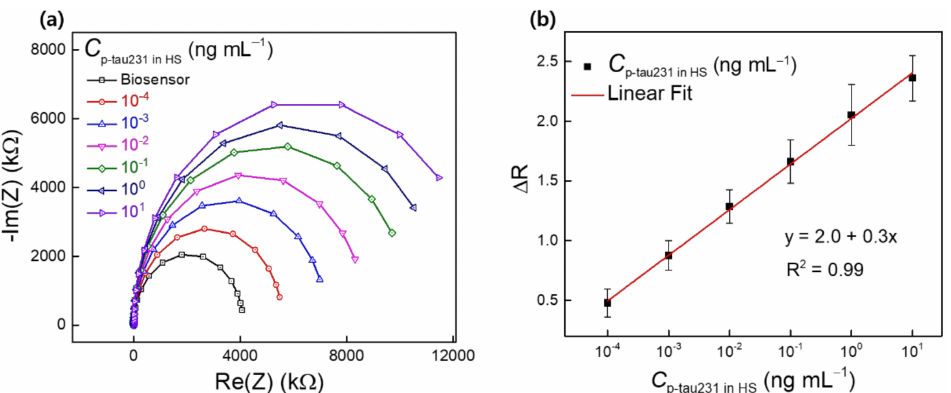
Figure 6. ( a ) Nyquist plots of the detection of p-tau231 in HS (10 − 4 –10 1 ng mL − 1 ) using the biosensor IWE/SAM/EDC-NHS/anti–p-tau231; ( b ) calibration curve for the detection of p-tau231 in HS (10 − 4 –10 1 ng mL − 1 ) estimated from the normalization ( ∆ R) of R ct value in Nyquist plots. Symbols and bars represent the average and standard deviation of the data ( n =